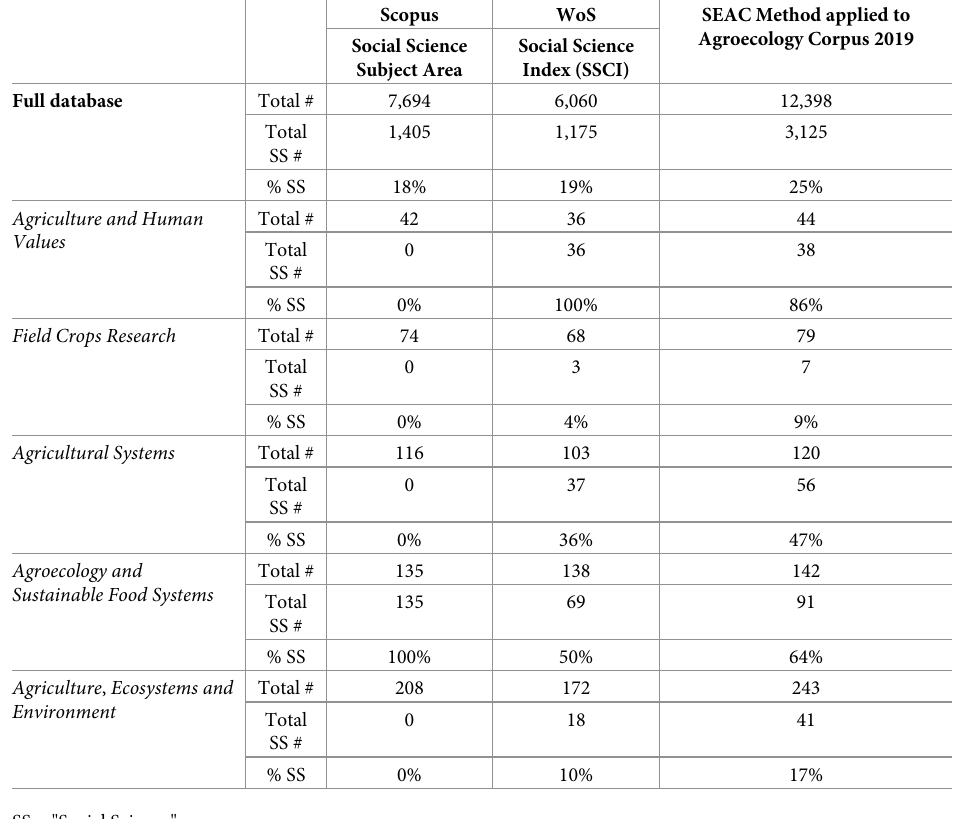
Table 8. A comparison of agroecology literature classified as “social science” in different databases.